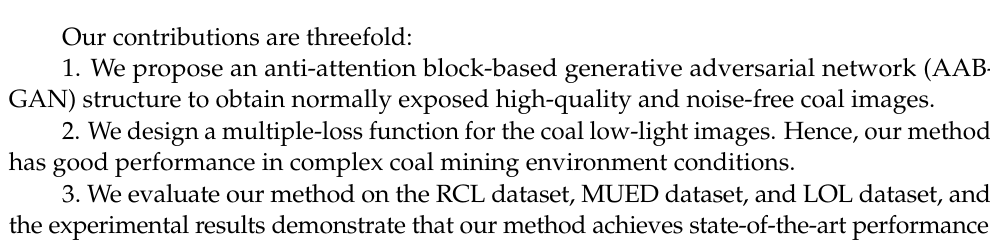
Figure 1. Visual results of different methods on coal image. Our model will enhance the global illumi- nation, suppresses color distortion and reduces the noise level. ( a ) Input. ( b ) LIME. ( c ) EnlightGAN. ( d )